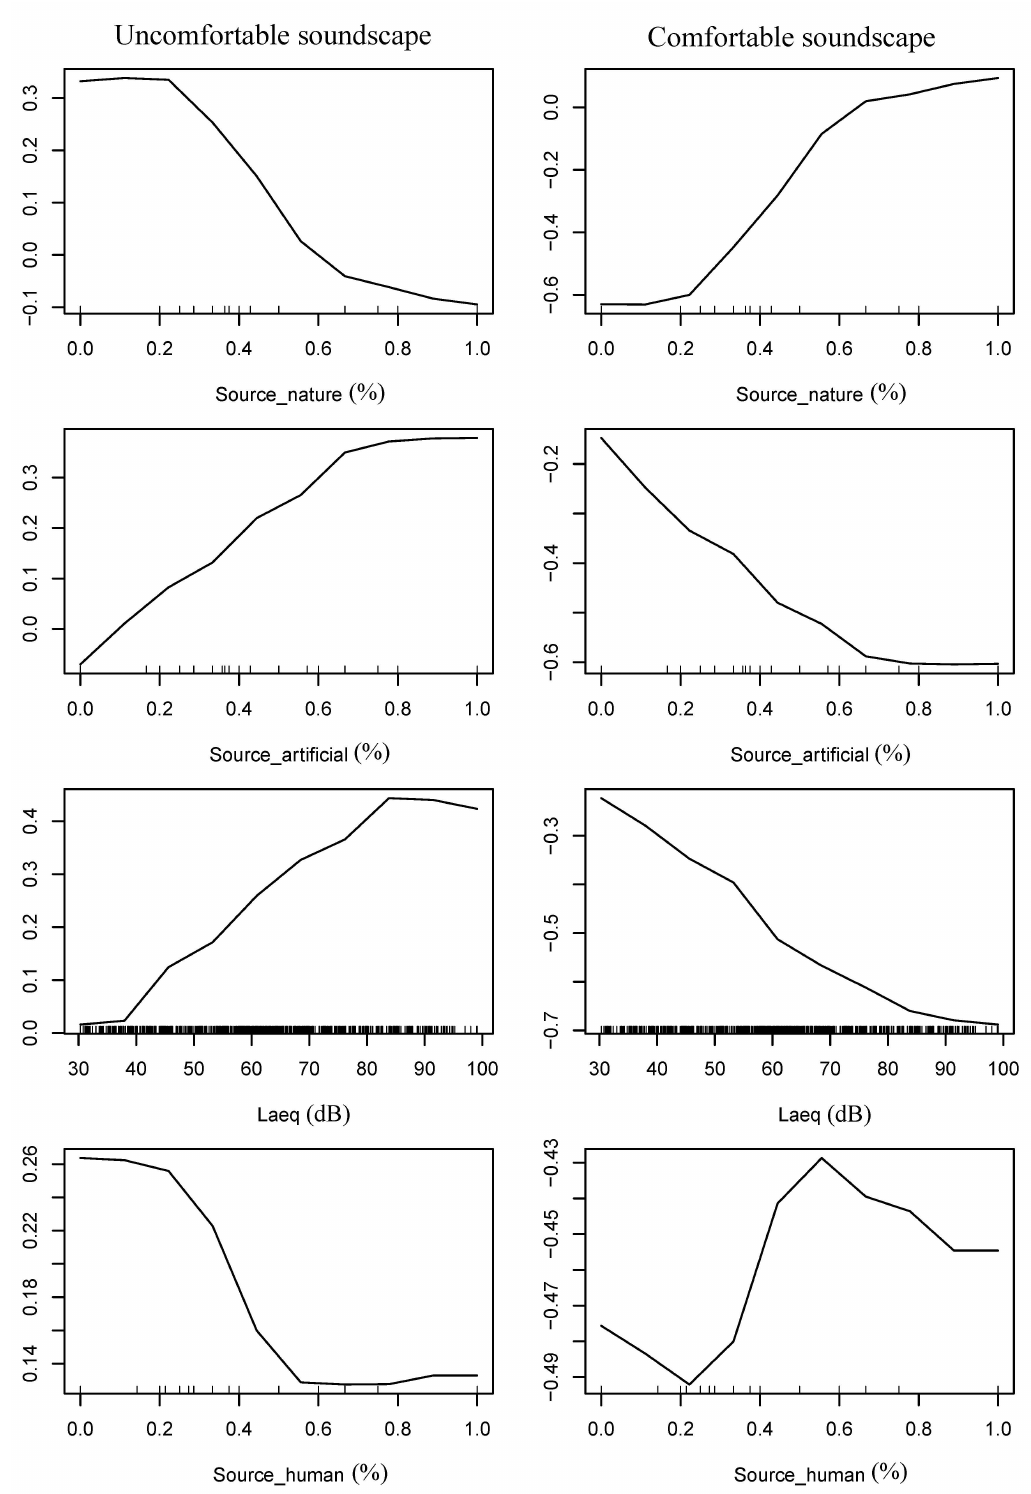
Figure A1. Partial dependence plot to understand the marginal effect of a single predictor on model prediction